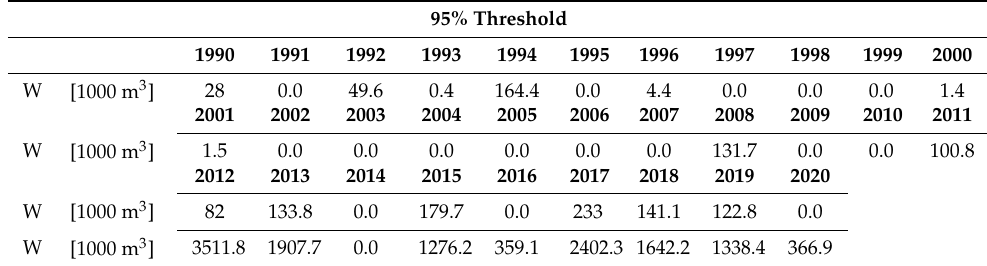
Table 6. The annual drought durations.